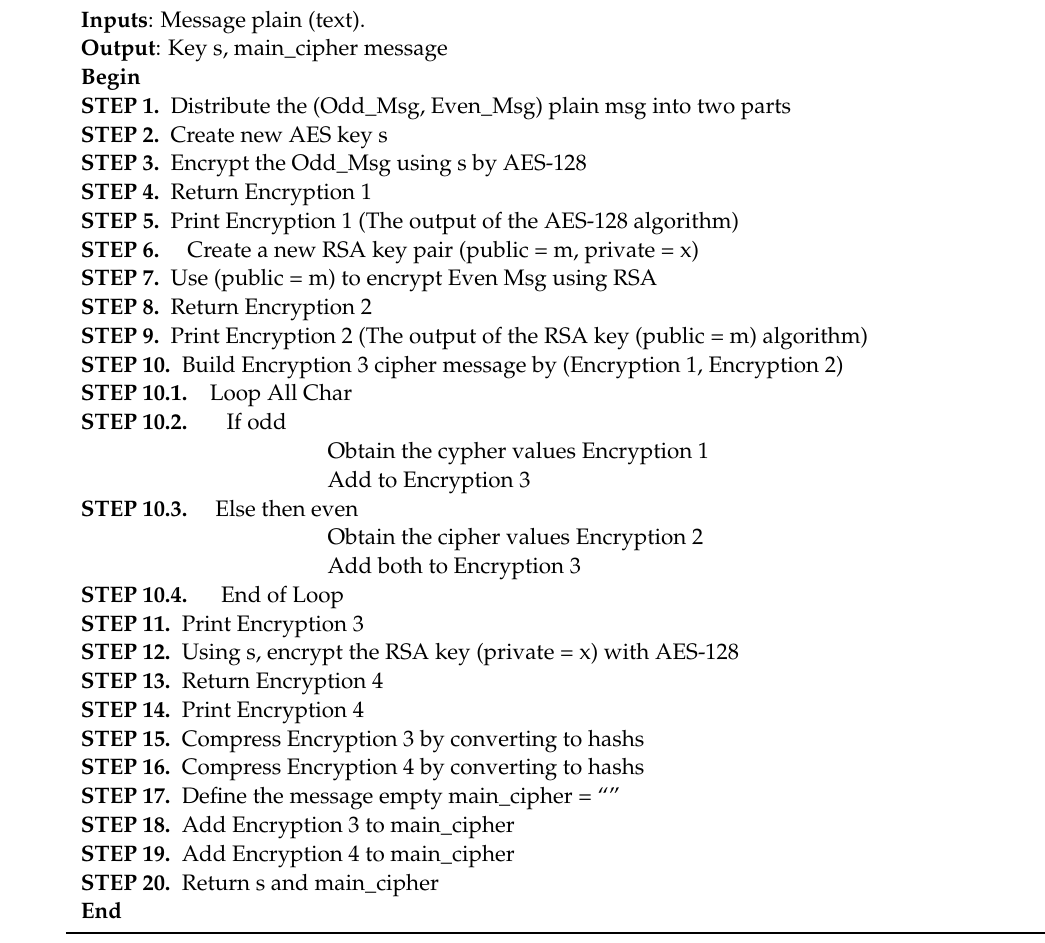
Proposed Encryption Algorithm 1: (AES and RSA) Hybrid